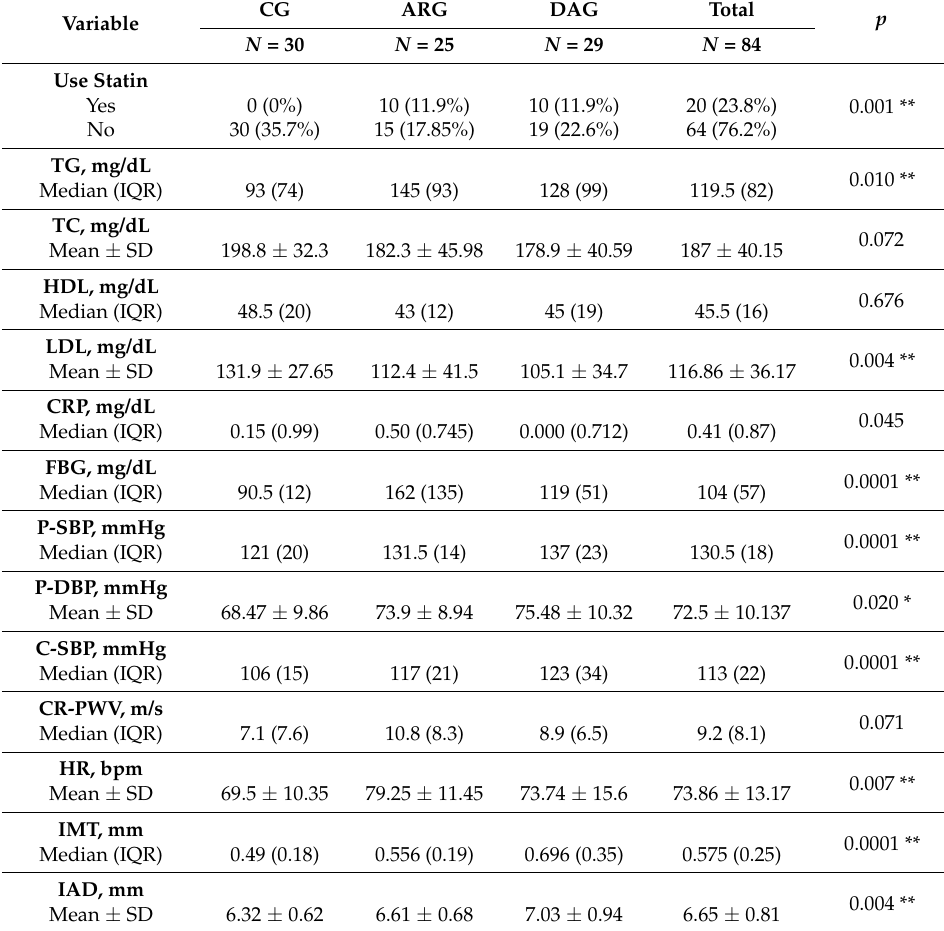
Table 2. Endocrine profile and vascular structure and kinetic measurements across the clinical groups. TG—triglycerides; TC—total cholesterol; CRP—C-reactive protein; FBG—blood glucose; HDL—high-density lipoprotein; LDL—low-density lipoprotein; IQR—interquartile range; HR—heart rate; C-SBP—central systolic blood pressure; P-SBP—peripheral systolic blood pressure; P-DBP—peripheral diastolic blood pressure; CR-PWV—carotid-radial pulse wave velocity; IMT—intima-media thickness; IAD—inter-adventitial